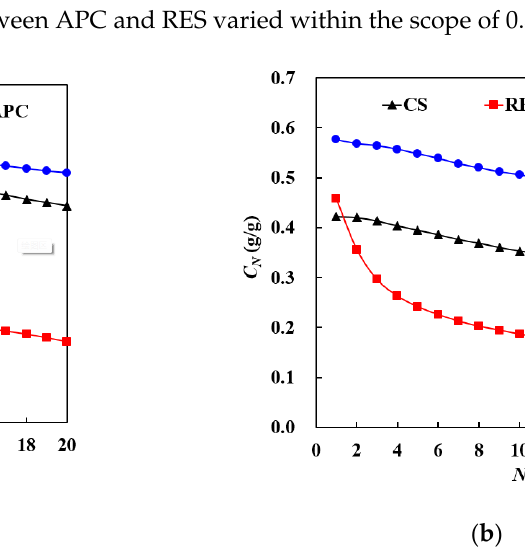
Figure 5. Influence of cycle number on the cyclic CO 2 capture characteristics of calcium-based sorbents: ( a ) relationship between X N and N; ( b ) relationship between C N and N.